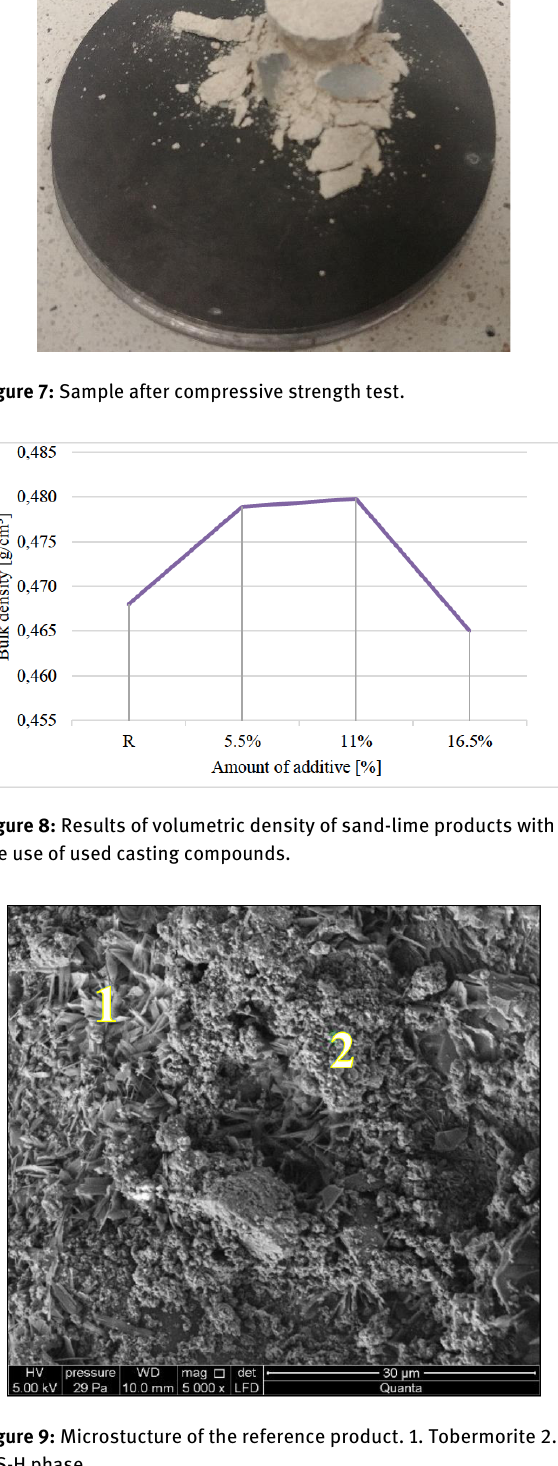
Figure 12: Results of volumetric